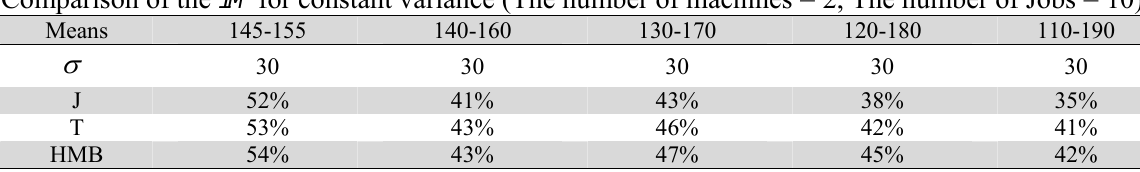
Comparison of the IM for constant variance (The number of machines = 2, The number of Jobs =